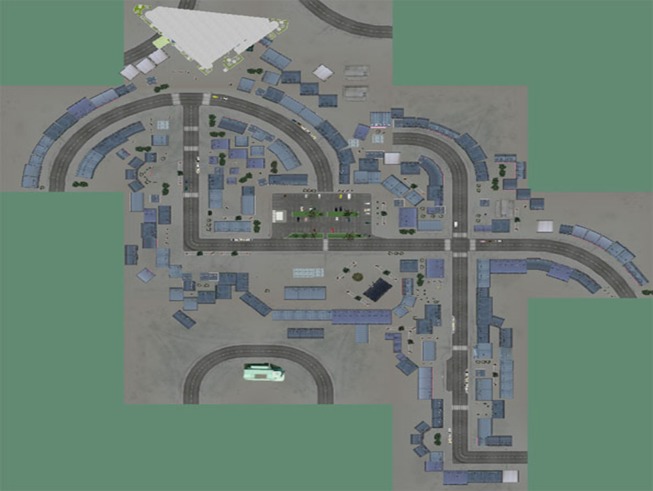
The map of the virtual environment given as a reference to the participants.